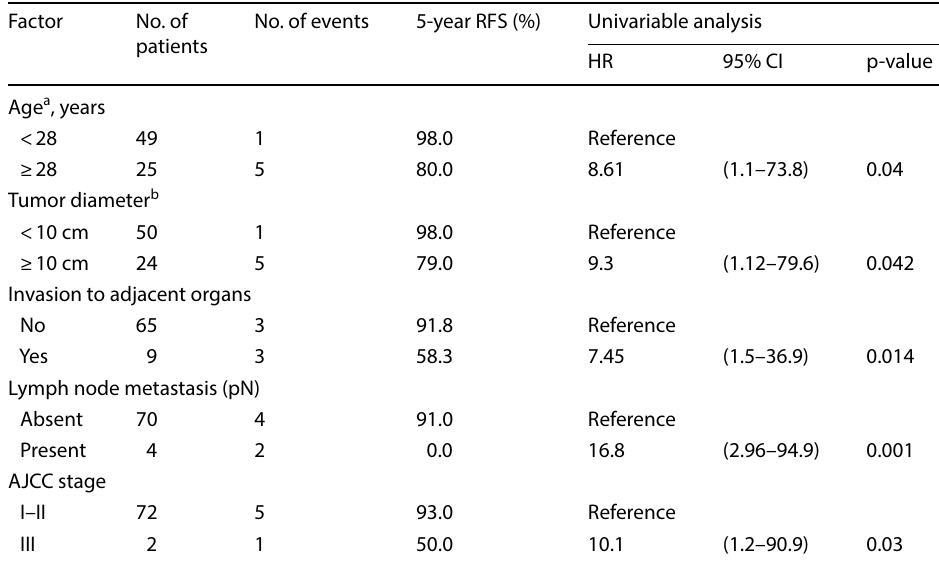
Table 5 Univariate Cox regression analysis of